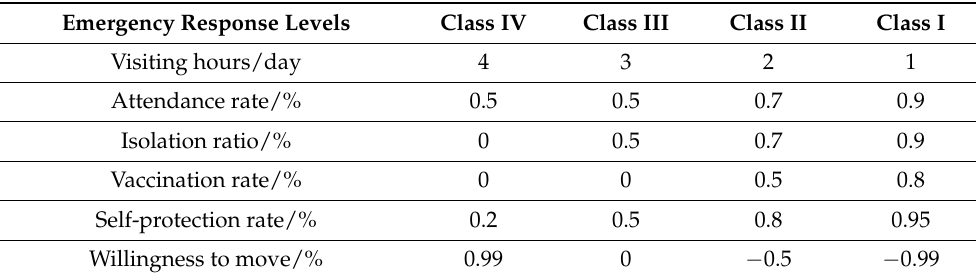
Table 5. Parameter settings for interventions under four emergency response